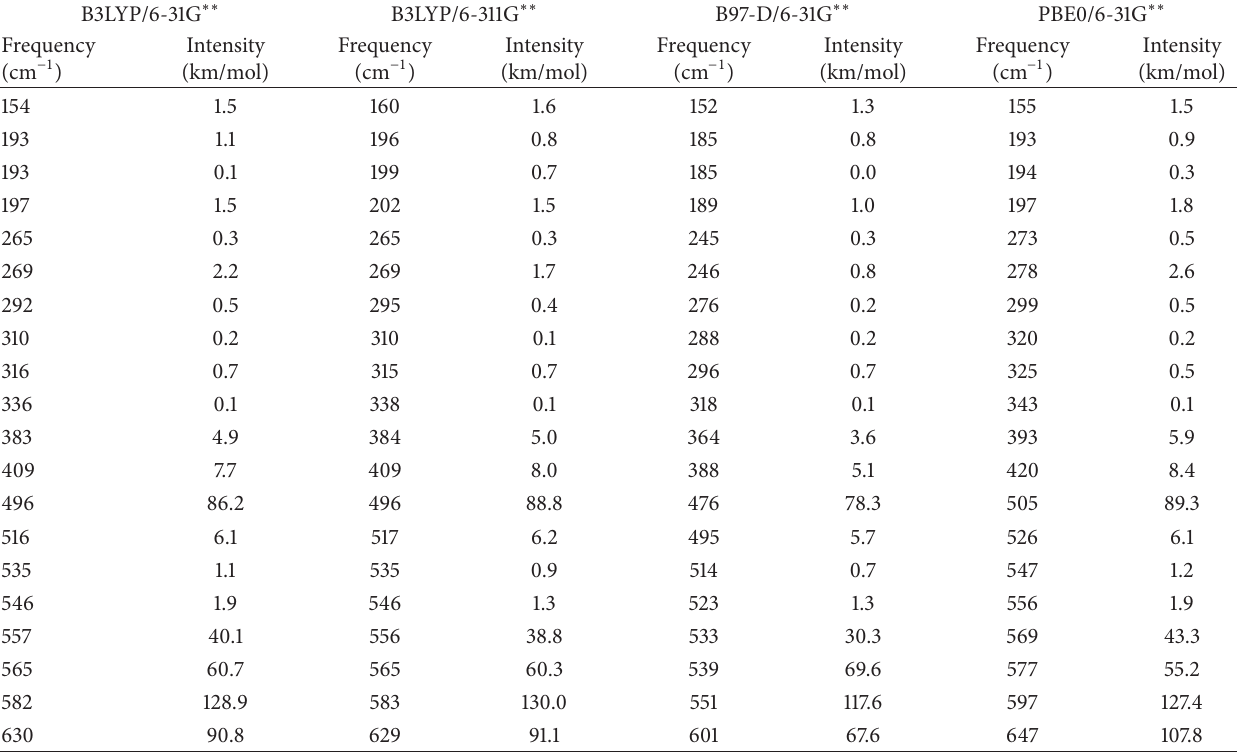
Table 2: Unscaled calculated frequency and intensity of the vibrations of cis-TFSI in the frequency range between 150 and 670 cm −1 , with various levels of theory and basis sets.